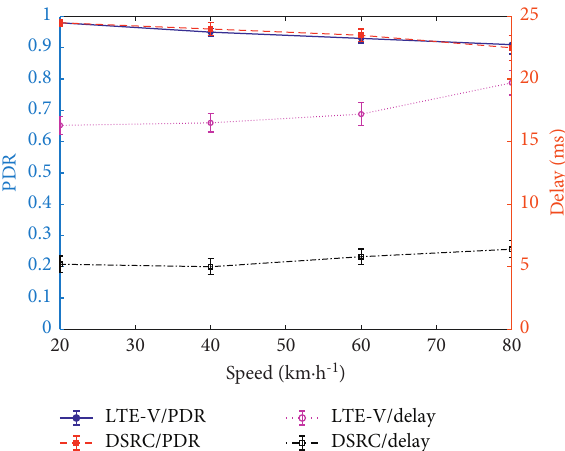
Figure 15: The results of feasibility for high-speed vehicle running in the cars-approaching